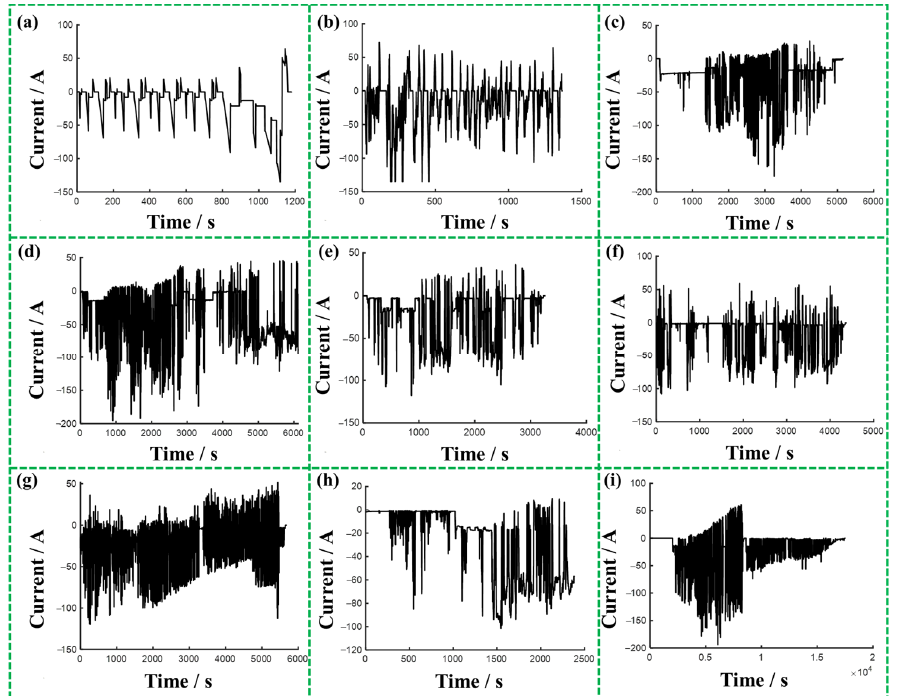
Figure 6. The current protocols used in NN training and validation. ( a ) NEDC operating condition. ( b ) FUDS operating condition. ( c )–( i ) Dynamic operating conditions selected from real vehicle data.